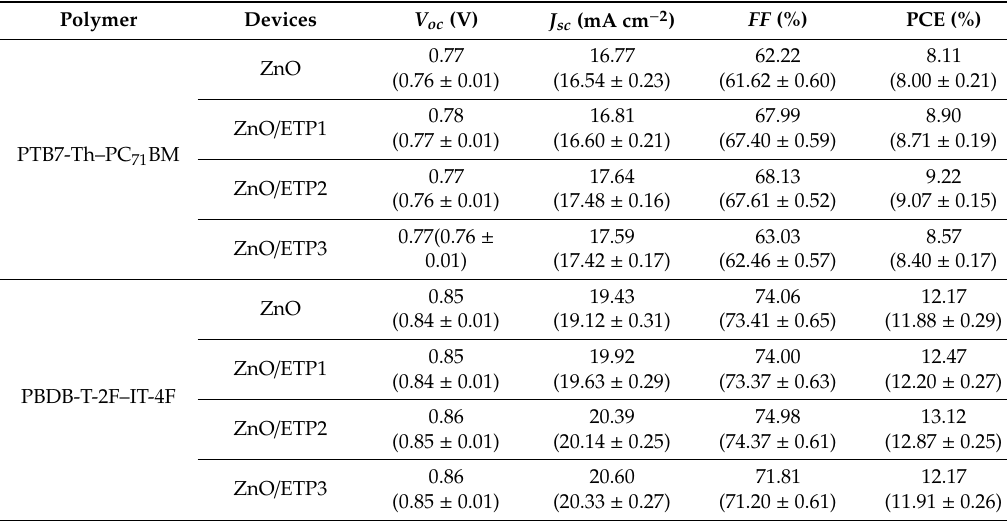
Table 2. Photovoltaic performance parameters of the devices based on PTB7-Th–PC 71 BM and PBDB-T-2F–IT-4F using ZnO and ZnO / ETP (di ff erent concentrations) as cathode bu ff er layers under the illumination of AM (air mass) 1.5 G, 100 mW cm − 2 .